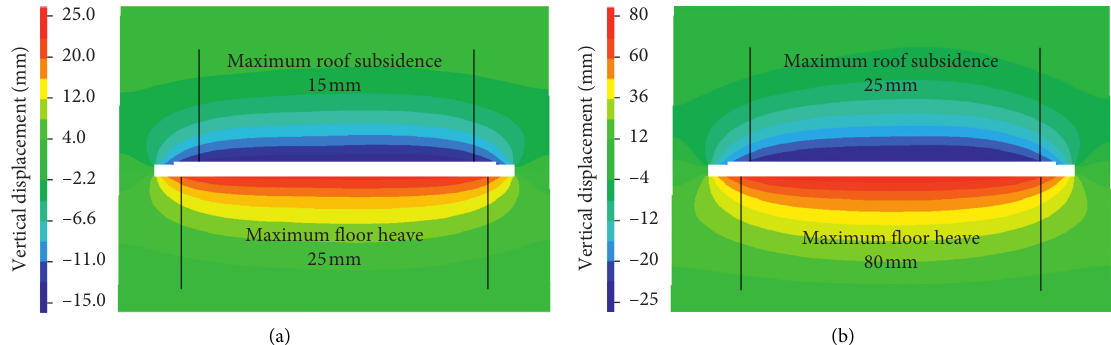
Figure 7: Cross section cloud map of vertical displacement profile. (a) Single hydraulic prop support. (b) Anchor cable support.